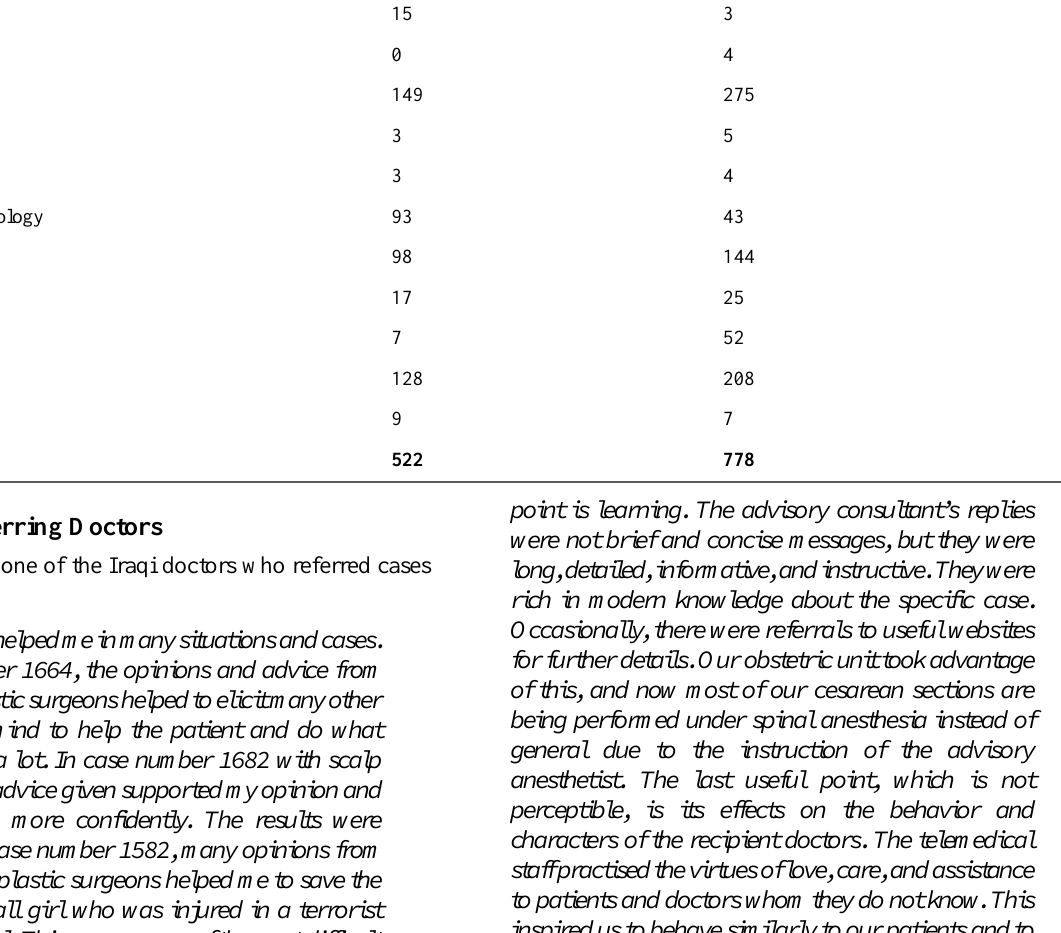
Rest of WorldMiddle